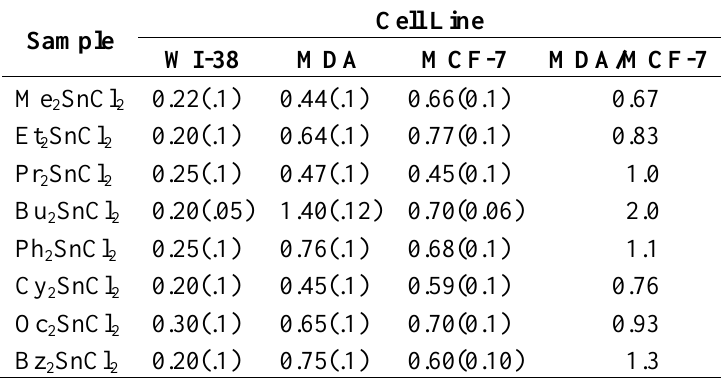
Table 7. GI concentrations (micrograms/mL) for organotin monomers for MDA and 50 MCF-7 cell lines.